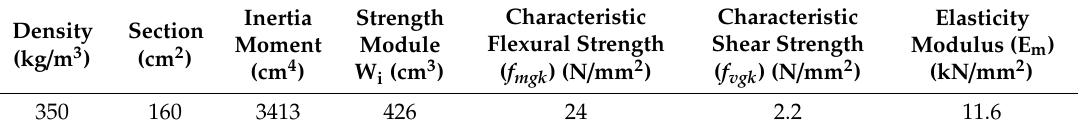
Figure 2. Wooden slab framework and connectors (left to right: joist, connectors, and board). Table 3. Physical and mechanical properties of the 100 × 160 mm 2 section of strength class GL24c.